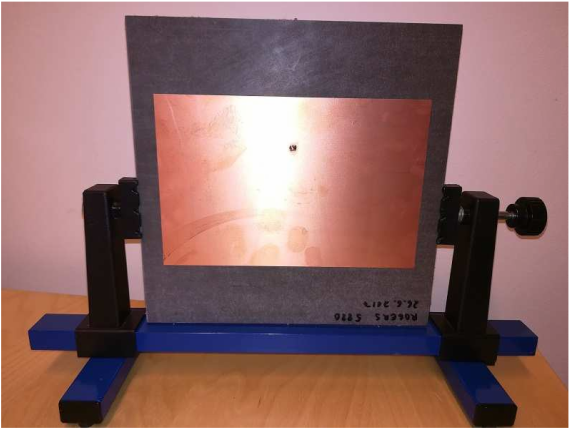
Figure 7. Prototyped antenna for energy transmission.